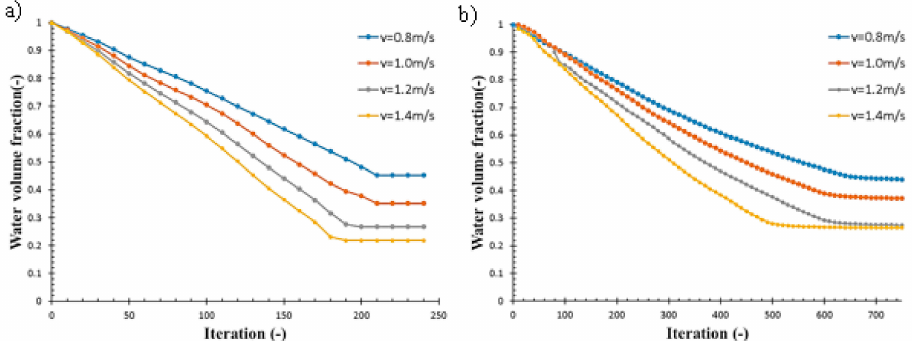
Figure 8. Variability of water volume remaining in the installation during the air blow-out obtained from calculations carried out using: ( a ) 2D model, ( b ) 3D model.